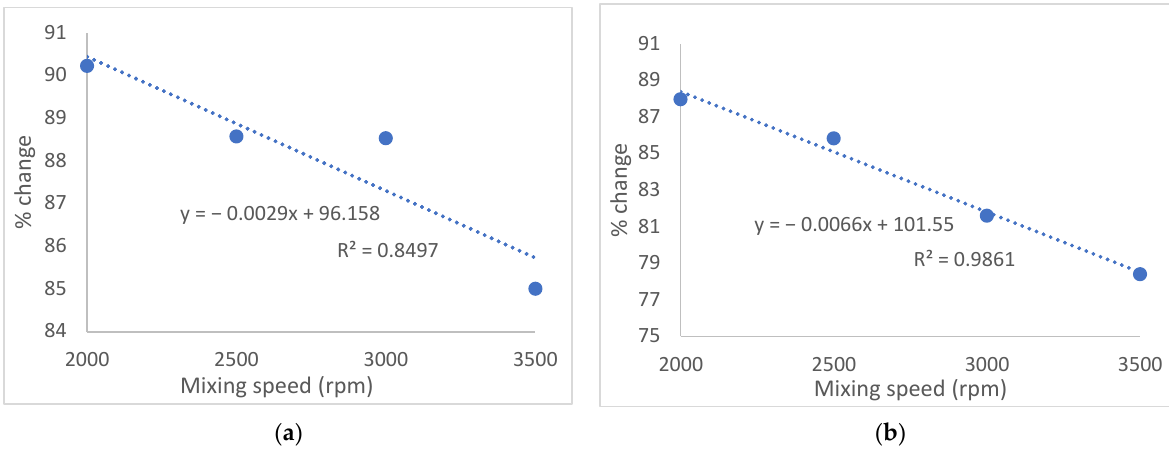
Figure 4. Percentage reduction in combing force as a function of shear mixing speed ( a ) Aminosensyl ( b ) CTAC